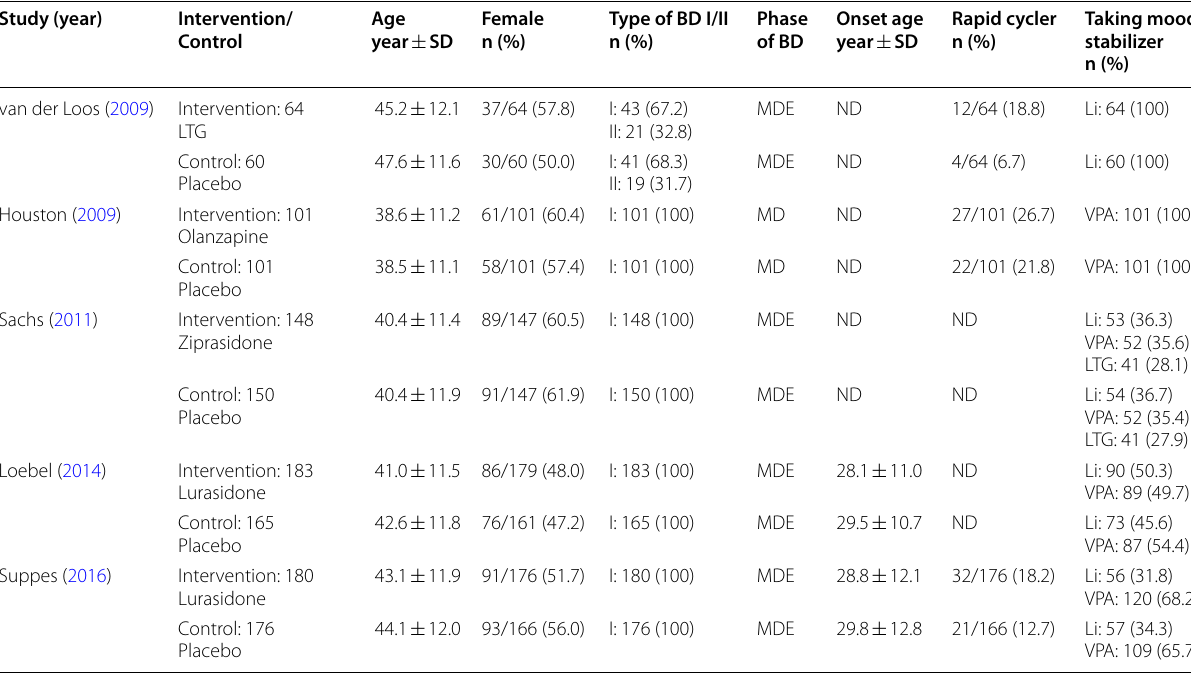
Continuous variable is indicated as mean SD. Nominal variable values are indicated as number (%) ± BD, bipolar disorder; Li, lithium; LTG, lamotrigine; MDE, major depressive episode; MD, mixed depression; n, number; ND, not described; VPA, valproate, including divalproex; SD, standard